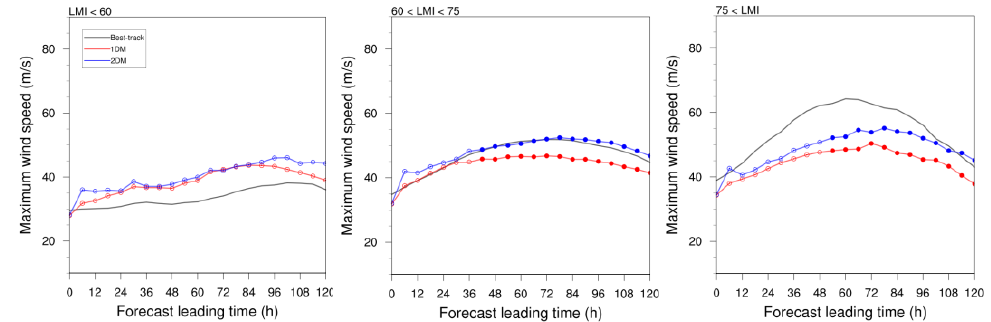
Figure 2. Time series of mean maximum wind speed forecast for TCs with three categories of intensity. The closed (opened) circle means that the difference between 1DM and 2DM is significant (not significant) at a 90% confidence level.